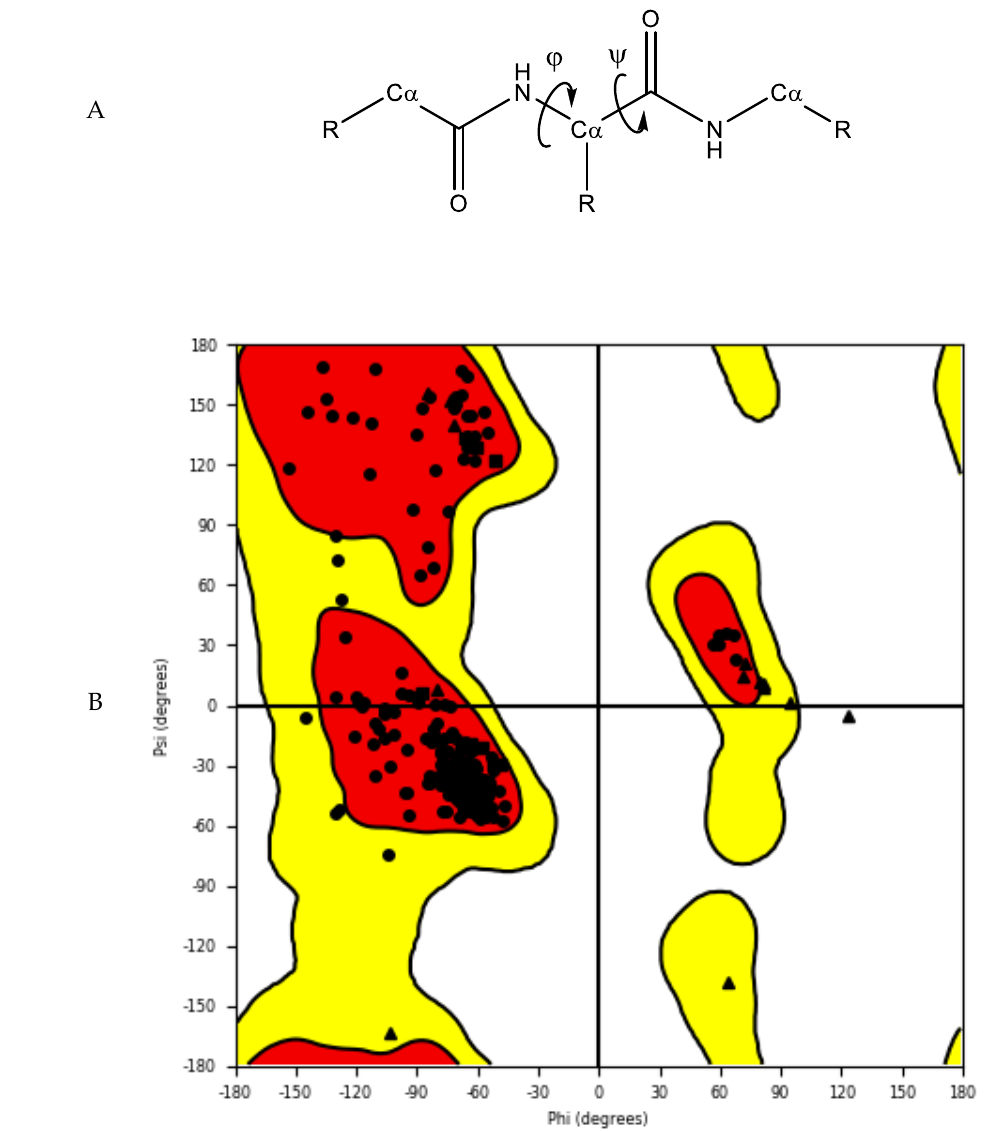
Figure 5. ( A ) Protein backbone with dihedral angles. ( B ) An example of a Ramachandran plot of crystal structure of human farnesyl pyrophosphate synthase (PDB ID: 4P0V) [91]. White: disallowed region; yellow: allowed region; red: favourable region.